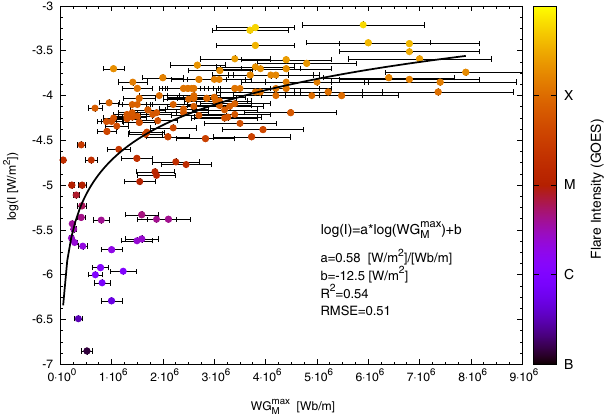
Fig. 4. The log value of GOES fl are intensity (log( I )) as function of the maximum WG M ( WG max ). The estimated errors are also given in M the lower right corner.